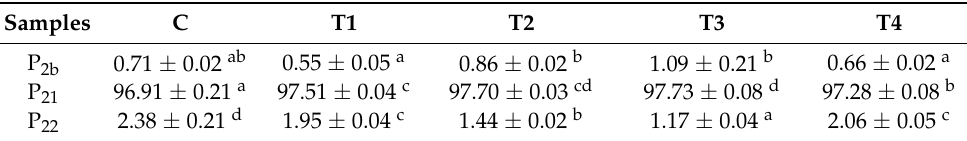
Table 6. T 2 relaxation corresponding peak area proportion of cooked pork batters prepared with various amounts of ORP.